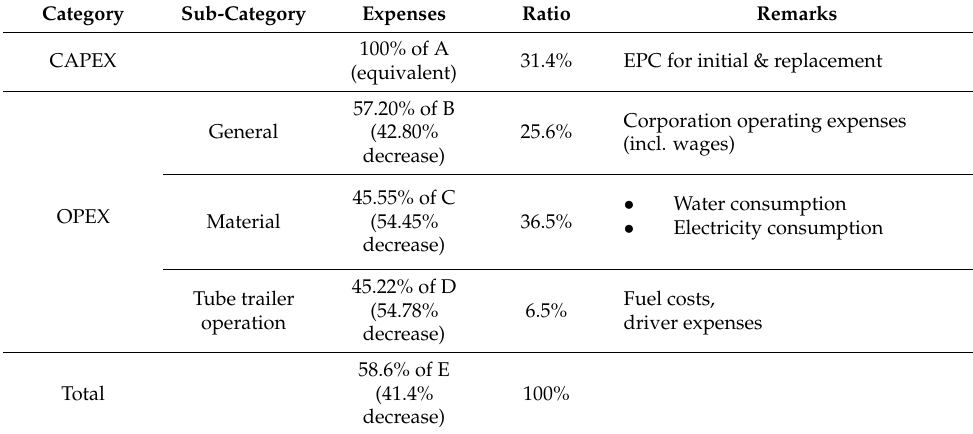
Table 26. Estimation of whole expenses and breakdown (Scenario